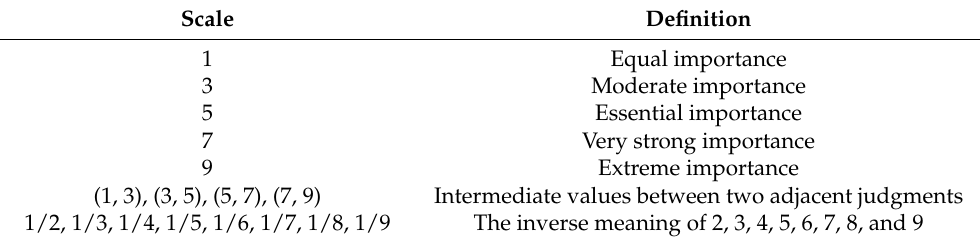
Table 2. The importance scale for filling the comparison matrix [11].